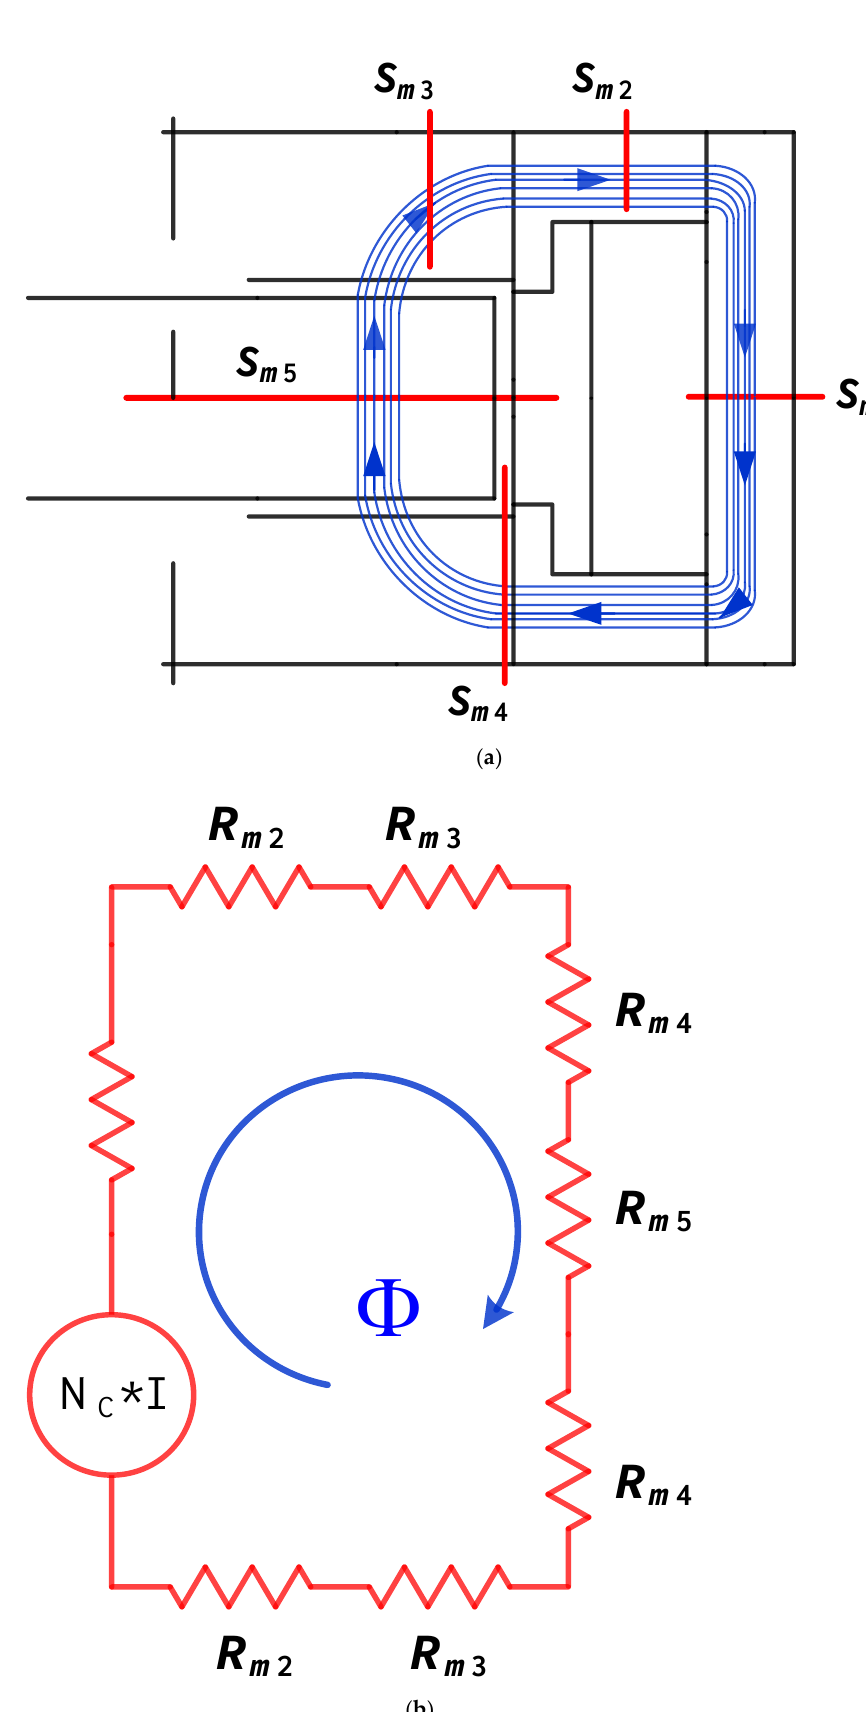
Figure 3. Equivalent magnetic circuit of radial MR valve: ( a ) control sections, ( b ) equivalent circuit.